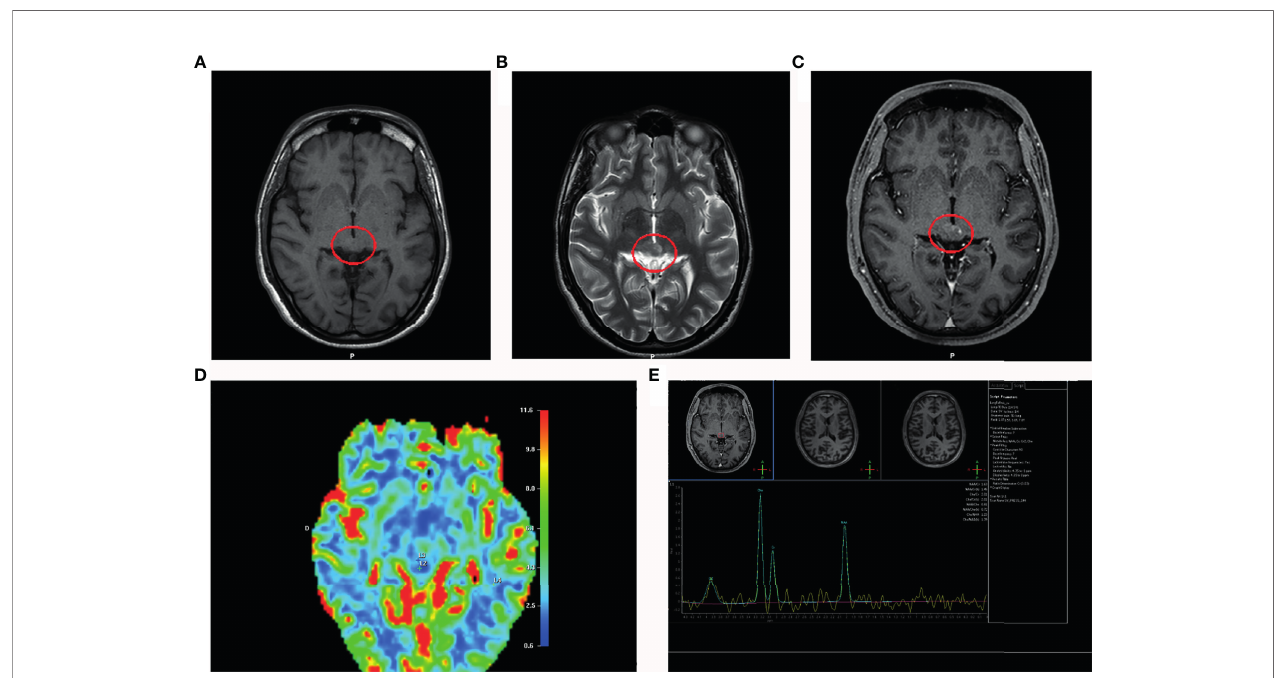
FIGURE 2 | MRI post-shunting (20 days). (A) MRI (T1-weighted image) shows a hypointensity signal periaqueductal area (red circle) with irregular pro fi le suggesting the presence of the lesion. (B) MRI scan (T2-weighted image) shows a hyperintensity signal in the same area (red circle). (C) Gadolinium T1-weighted image shows a low focal contrast enhancement of the lesion in the periaqueductal area. (D) Proton magnetic resonance spectroscopy (MRS) reveals elevated cholin peaks (cholin/ creatinine ratio at 1,9) in addition to reduced NAA (N-acetylaspartate). (E) Perfusion-weighted imaging (PWI) shows a low cerebral blood volume (CBV) in the area of